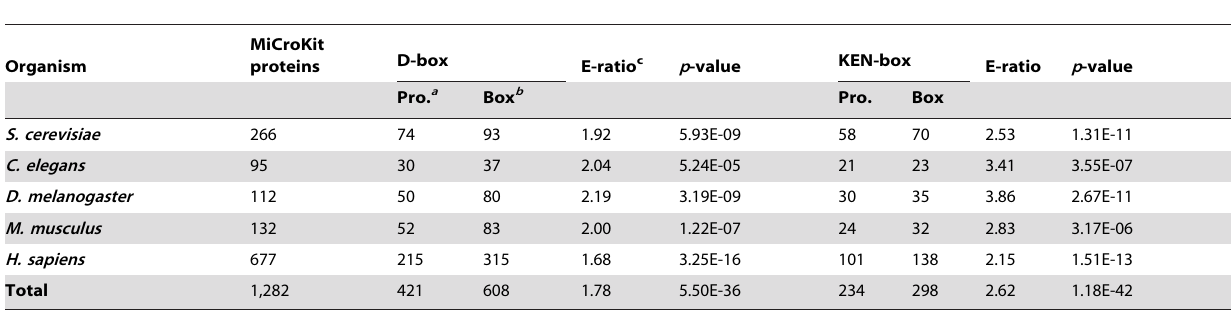
a Pro., the number of predicted D-box or KEN-box proteins; b Box, the number of predicted D-boxes or